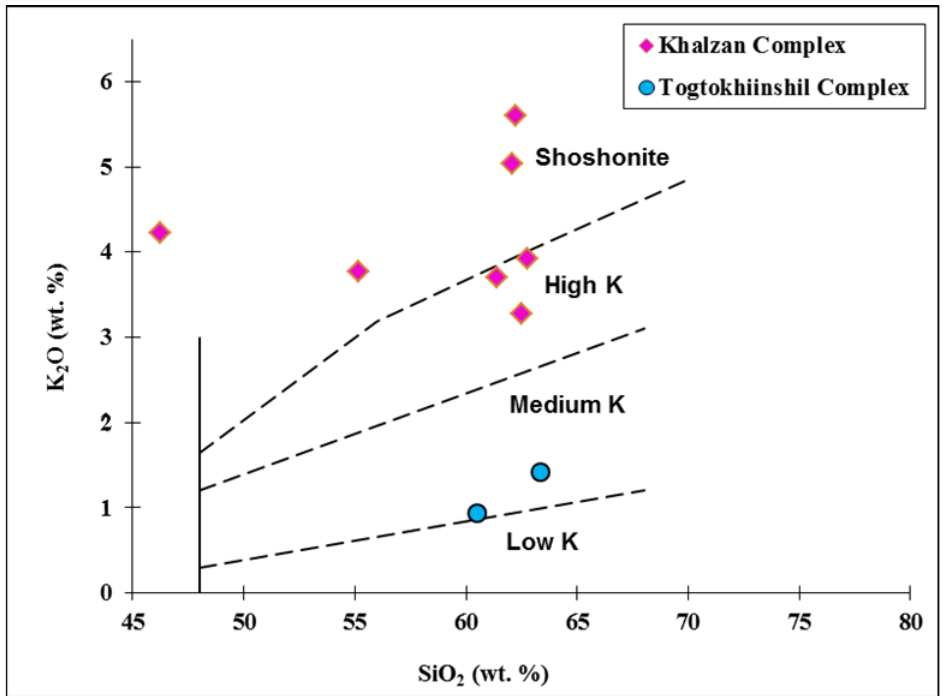
Fig. 11. K O vs SiO variation diagram with subdivisions of Le Maitre (1989) for the 2 2 Khalzan and the Togtokhiinshil complex rocks in the Ulaan Del deposit area